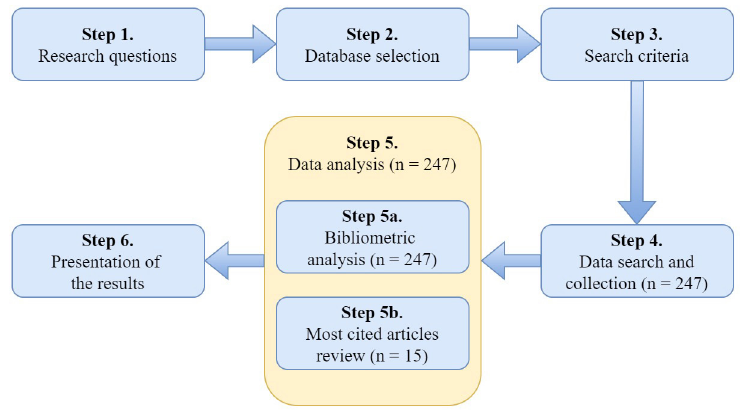
Figure 1. Research design (source: created by the